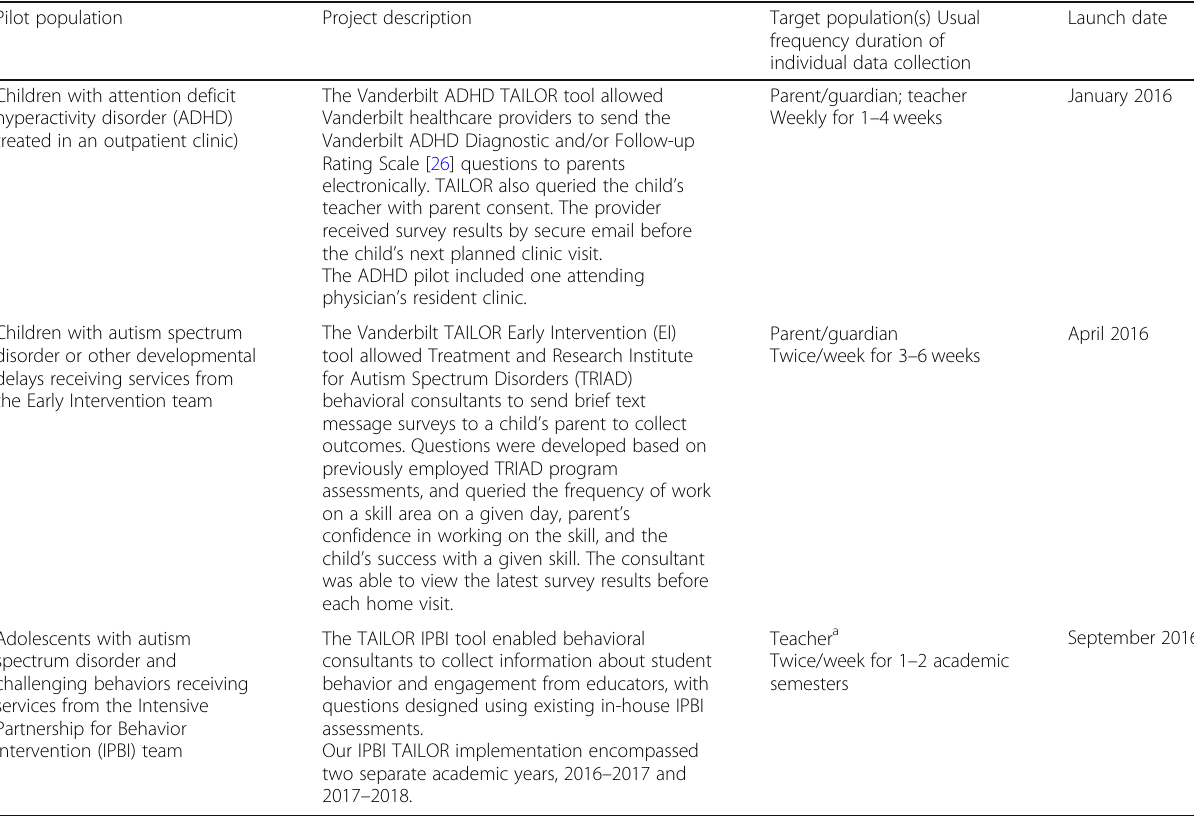
Table 1 Overview of TAILOR pilot projects Pilot population Project